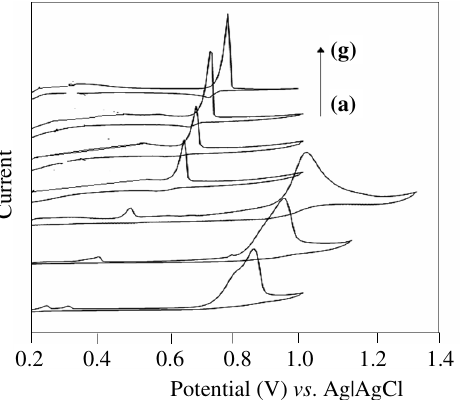
Figure 3. Cyclic voltammograms of 1a (6 x 10 -5 M) at pH (a)1.6, (b) 3.8, (c) 6.8, (d) 8.2, (e) 9.2, (f) 10.1 and (g) 11.5 on SMDE (6.25 x 10 -6 m 2 ) at 50 mVs -1 with KCl (0.05